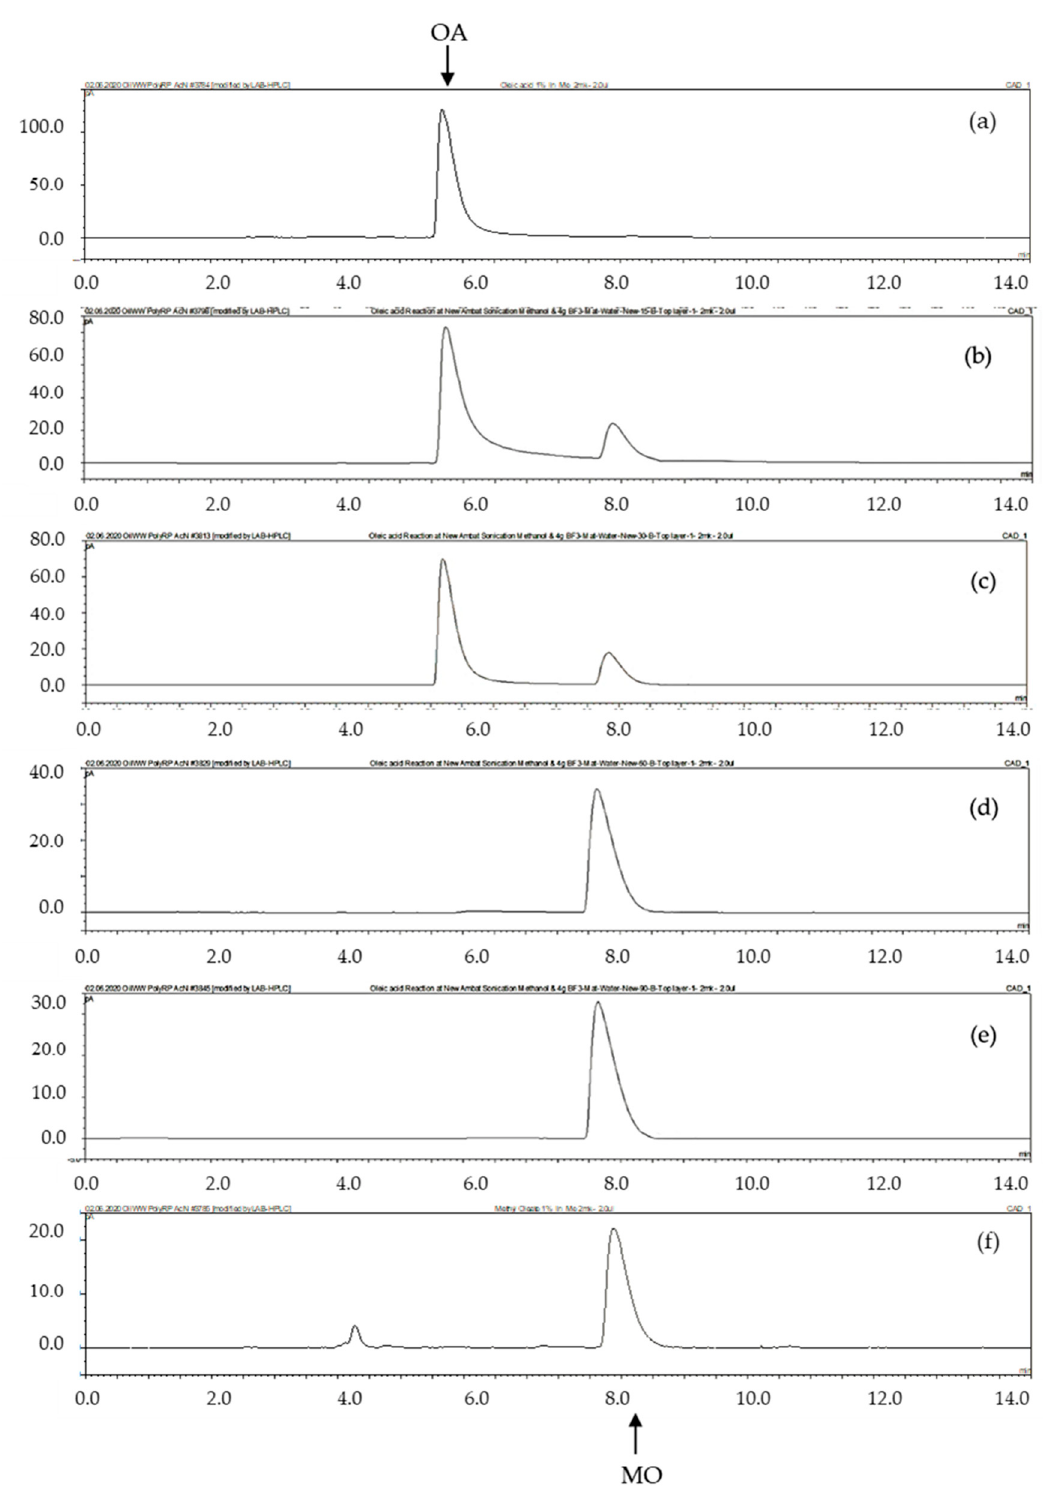
Figure 4. Esterification of oleic acid (OA) by methanol under ultrasonic activation using the BSil matrix as a catalyst. HPLC chromatograms of OA ( a ) before esterification, and after esterification: ( b ) after 15 min, ( c ) 30 min, ( d ) 60 min and ( e ) 90 min. ( f ) A commercial standard of methyl oleate (MO).